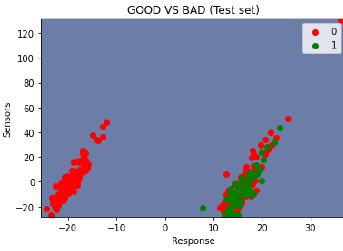
Figure 13. Testing set of Good vs Bad data